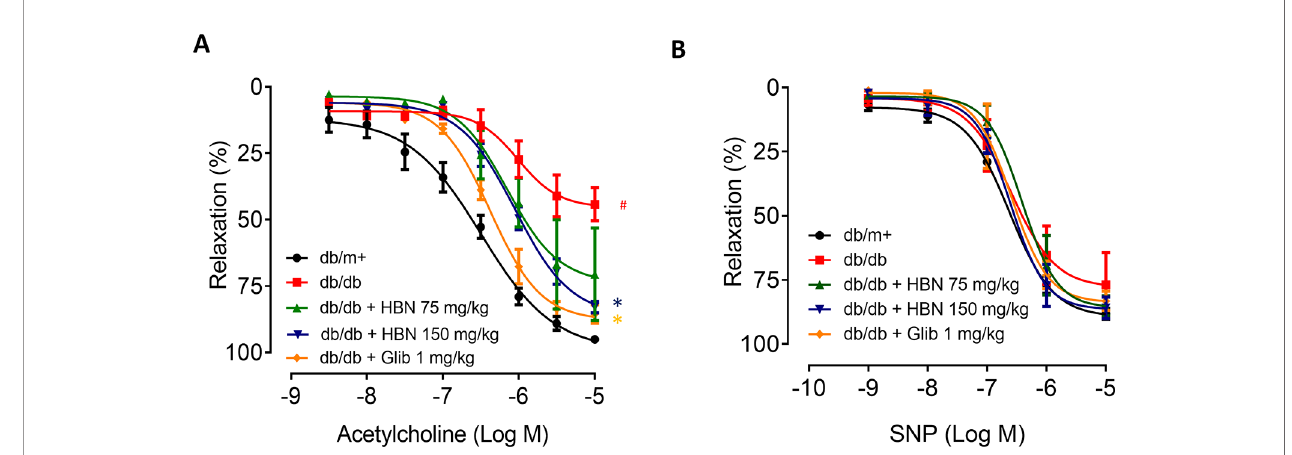
FIGURE 3 | The effect of four week ’ s treatment of hydrolyzed bird nest (HBN, 75 and 150 mg/kg) and glibenclamide (1 mg/kg) on (A) acetylcholine-induced endothelium-dependent relaxation (EDR) and (B) sodium nitroprusside-induced endothelium-independent relaxation (EIR) in db/db mice. Results are means ± SEM of six experiments. # P < 0.05 compared with db/m+, *P < 0.05 when compared with